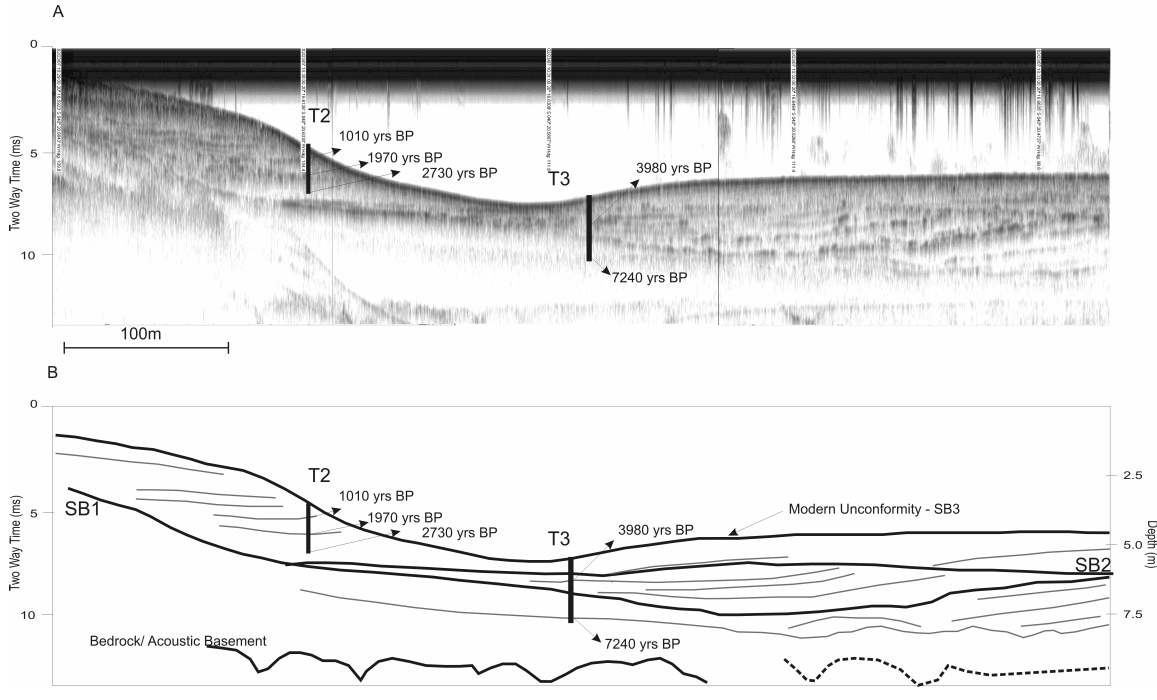
Fig. 4 – High-resolution seismic section (a) and interpretation (b). Core locations and radiocarbon dates are presented. See text for the meaning of SB1 and